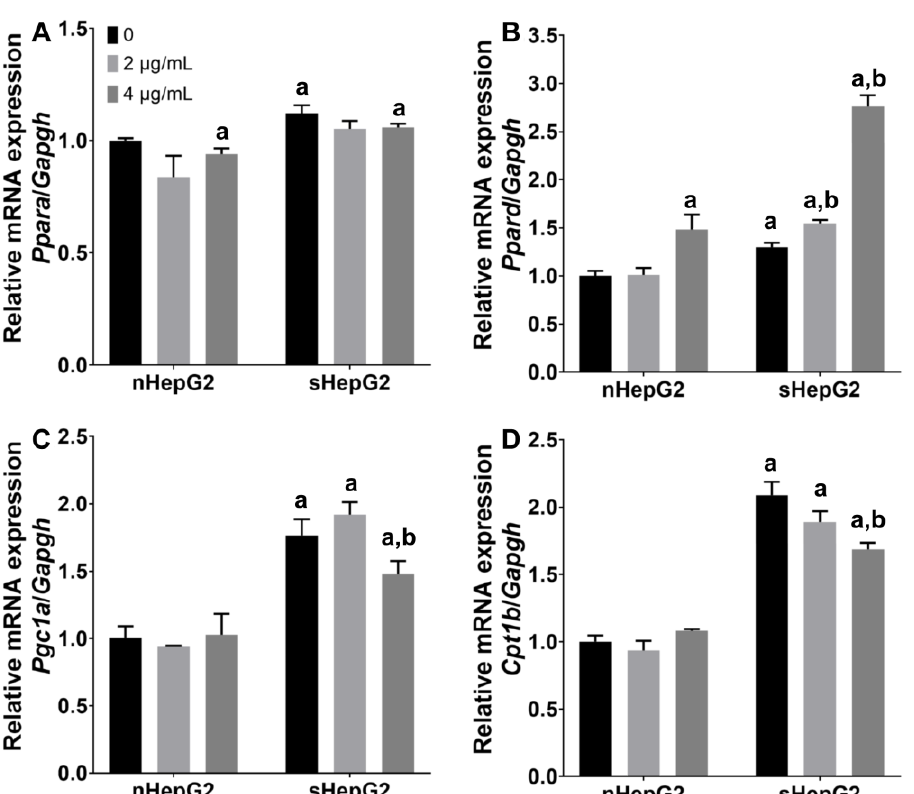
Figure 6. Expressions of FAO-related genes in nHepG2 and sHepG2 cells in response to Ag NP exposure. ( A – D ) Relative expressions of Ppara ( A ), Ppard ( B ), Pgc1a ( C ), and Cpt1b ( D ) in nHepG2 and sHepG2 cells exposed to 0, 2, and 4 μg/mL Ag NPs for 24 h. Data are shown as means ± s.d., n = 3. a p < 0.05, compared with vehicle control of nHepG2 cells. b p < 0.05, compared with vehicle control of sHepG2 cells.